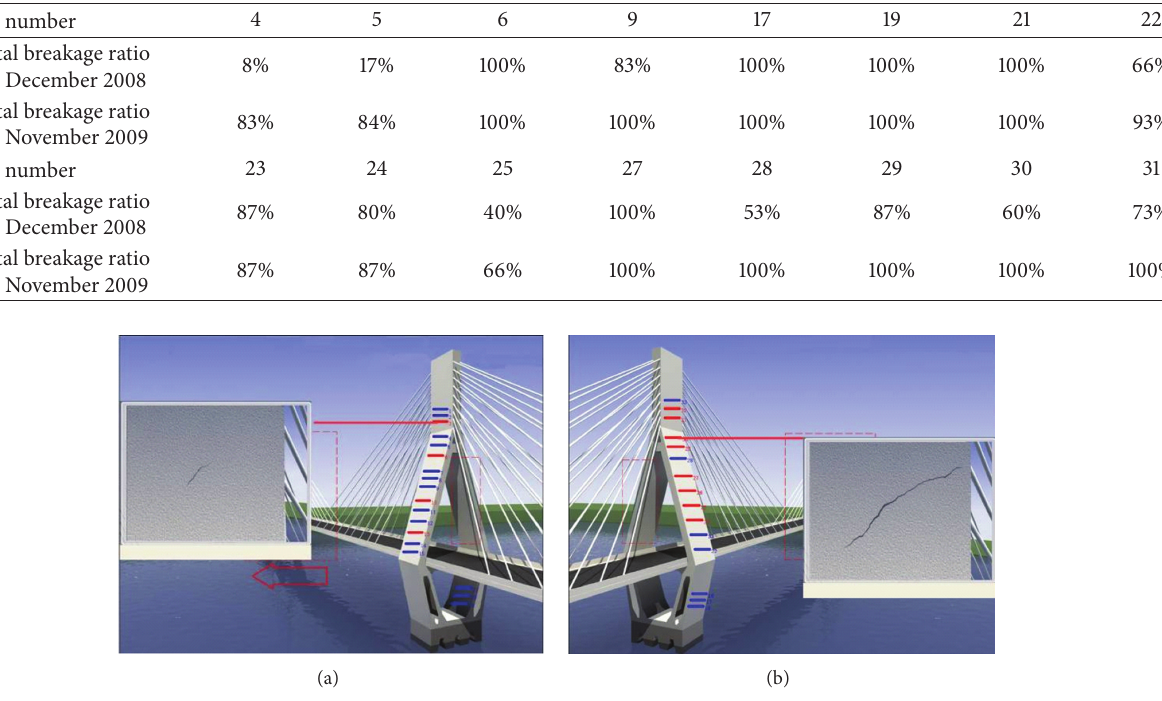
Figure 14: Visual recurrence of the real crack: (a) 4th smart film of tower no. 2 and (b) 30th smart film of tower no. 2.